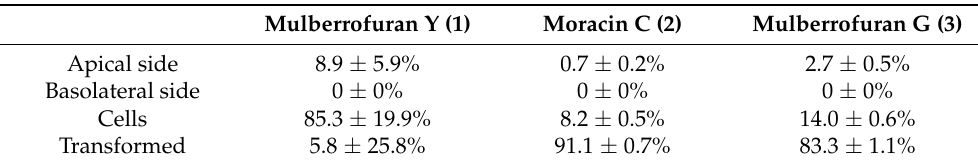
Table 1. List of 2-arylbenzofurans monitored and detected in the Transwell TM cell system by the LC/MS system. Mulberrofuran G ( 3 ) and moracin C ( 2 ) were mostly metabolized. Mulberrofuran Y ( 1 ) was stable and most of it was retained in the cells. All compounds were able to pass into cells but not to the basolateral side in their original form.